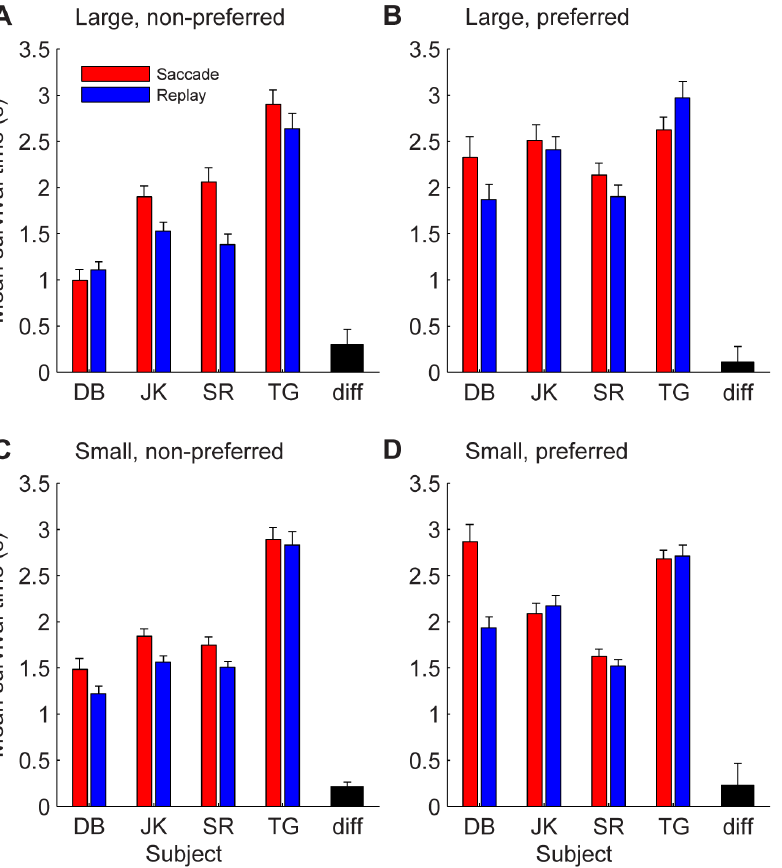
Figure 10. Dominance survival time after retinal image shifts. Average dominance survival time after large (A,B) and small (C,D) retinal image shifts in the saccade (red) and replay (blue) conditions. A,C: Survival of the percept of the non-preferred eye. B,D: Survival of the percept of the preferred eye. Error bars on colored bars show standard deviations. Black bars show the average difference between the two conditions over all four subjects with SEM.